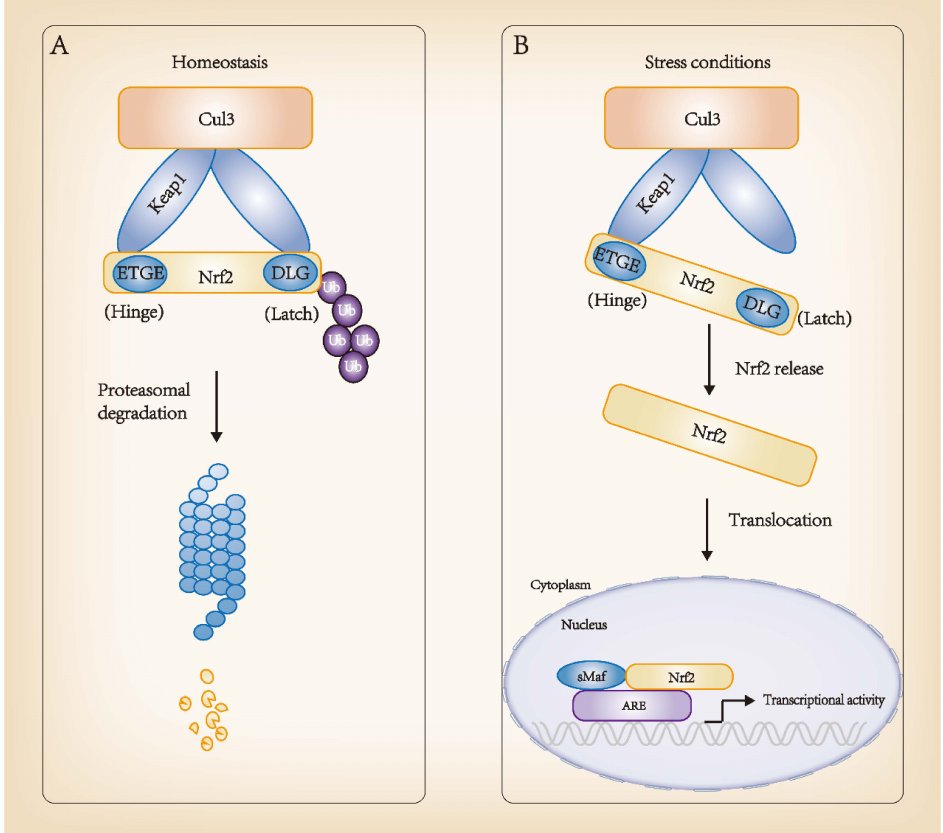
Figure 2. Regulation of Nrf2 molecular mechanisms. ( A ) Homeostasis: high affinity ETGE and low affinity DLG sites of Nrf2 bind to its inhibitor, Keap1, in the cytoplasm and interact with Cul3- Rbx1 E3 ubiquitin ligase, consistently leading to Nrf2 ubiquitination and proteasomal degradation. ( B ) Stress conditions: Keap1 changes its conformation and dissociates from Nrf2. Nrf2 translocates into the nucleus and forms a dimer with sMaf. The complex binds to ARE sequences, promoting the transcription of target genes, such as detoxification genes. ARE, antioxidant responsive